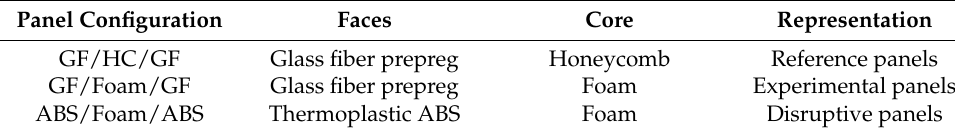
Table 1. Description of the panel configurations evaluated in this work. Panel